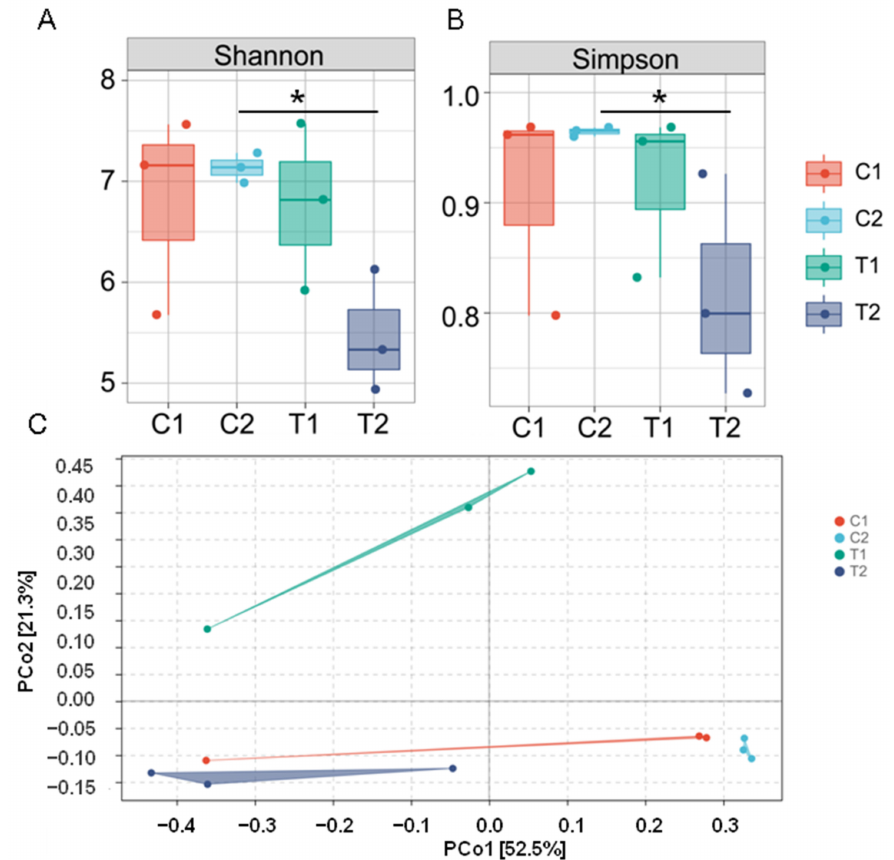
Figure 2. Intestinal microbiome diversity among Cipangopaludina cathayensis treatment groups C1 (control treatment; 25 ± 1 ◦ C, day 3), C2 (control treatment; 25 ± 1 ◦ C, day 7), T1 (high-temperature treatment; 32 ± 1 ◦ C, day 3), and T2 (high-temperature treatment; 32 ± 1 ◦ C, day 7). ( A ) Shannon diversity index; ( B ) Simpson diversity index; ( C ) Bray–Curtis distances calculated and visualized through principal coordinates analysis (PCoA; ellipses were drawn with 95% confidence